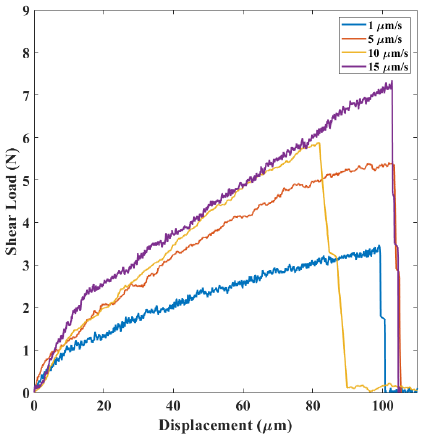
Figure 7. Load-displacement results in category